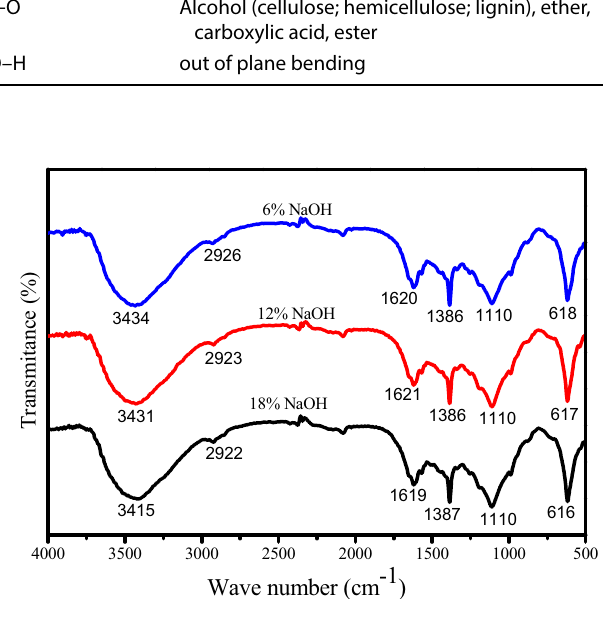
Fig. 3 FTIR analysis of alkali-treated Y.alpina bamboo fiber at differ- ent